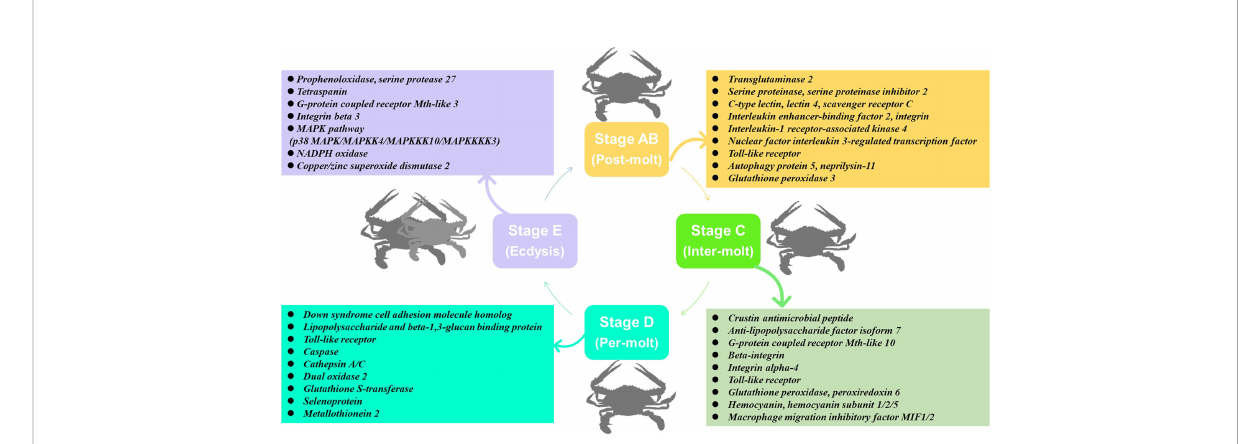
FIGURE 11 The speculated key genes and pathway for immune response during the molting cycle of P. trituberculatus based on the transcriptome